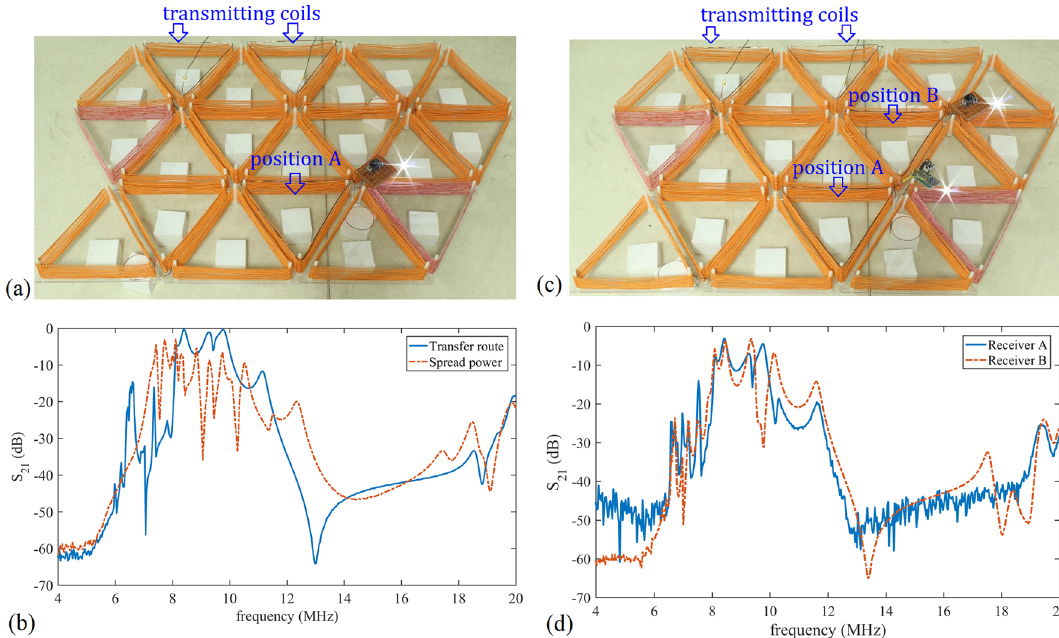
Figure 11. ( a ) The 20-unit system. The receiving coil is in position A . ( b ) S 21 of the power transfer route solution (solid line) and the spreading power solution (dashed line) in one-receiver experiment. ( c ) The 20-unit system with two receiving coils in position A and B . ( d ) The experimental results of S 21 and S 31 in two-receiver experiment.